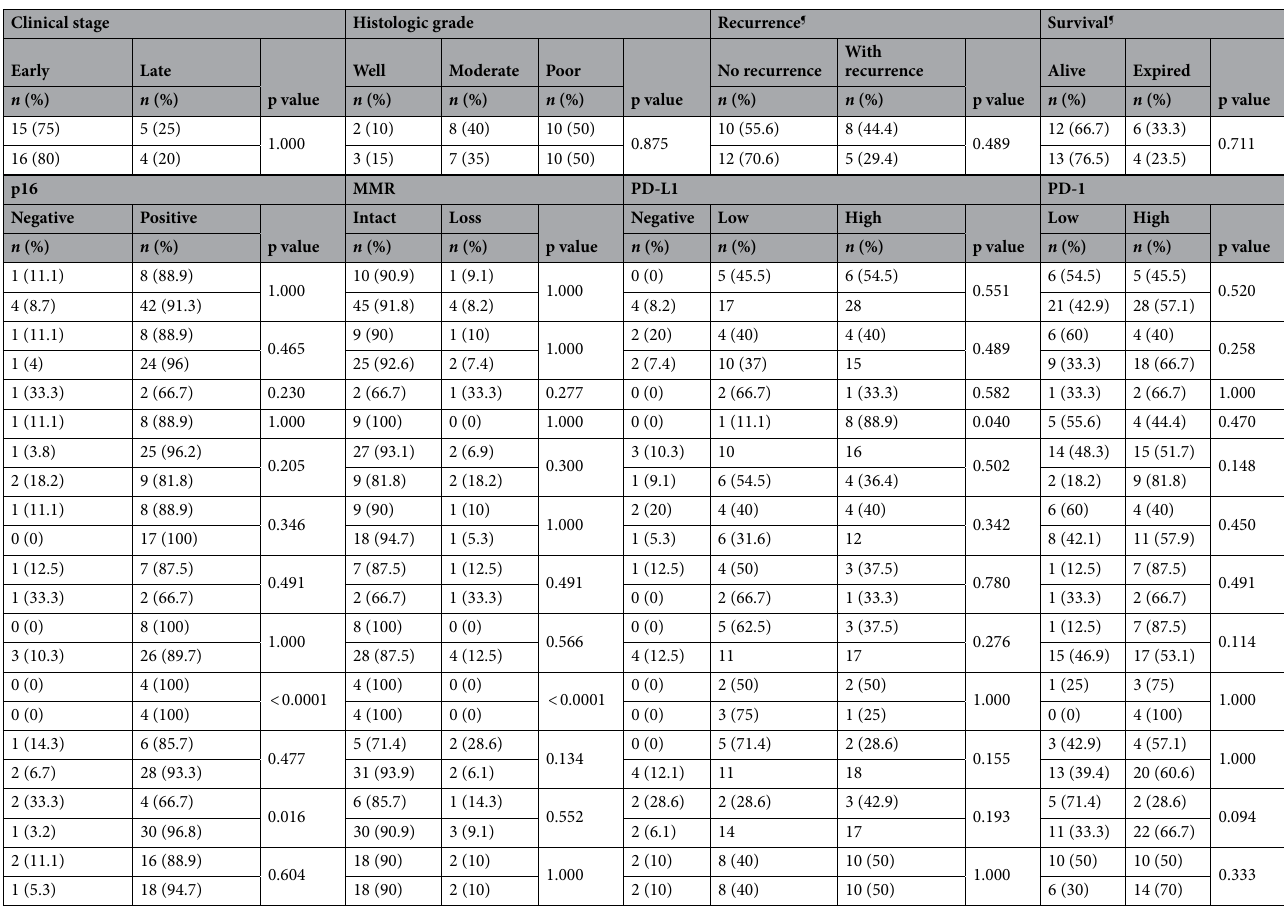
Table 3. Clinicopathologic characteristics of patients in relation to HPV results. HPV human papilloma virus, MMR mismatch repair proteins, PD-1 programmed cell death 1, PD-L1 programmed cell death 1 * Excludes